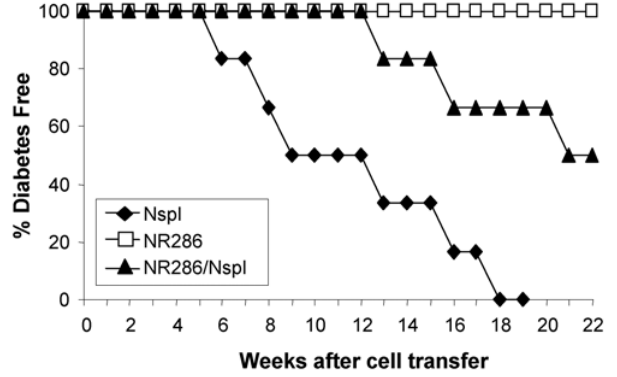
Figure 3. NR286 T cells inhibit diabetes development. NOD/scid recipient mice were transferred with either NOD mouse splenocytes (Nspl)(1 6 10 7 cells/mouse) alone, NR286 T cells alone (1 6 10 7 cells/ mouse), or co-transferred with an equal numbers of both NR286 T cells and Nspl. The difference of diabetes onset and development between co-transferred mice and Nspl single transferred mice was significant (p , 0.002).NOD mouse splenocytes were isolated from 7–8 wk old female NOD mice. At least 8 mice were studied in each